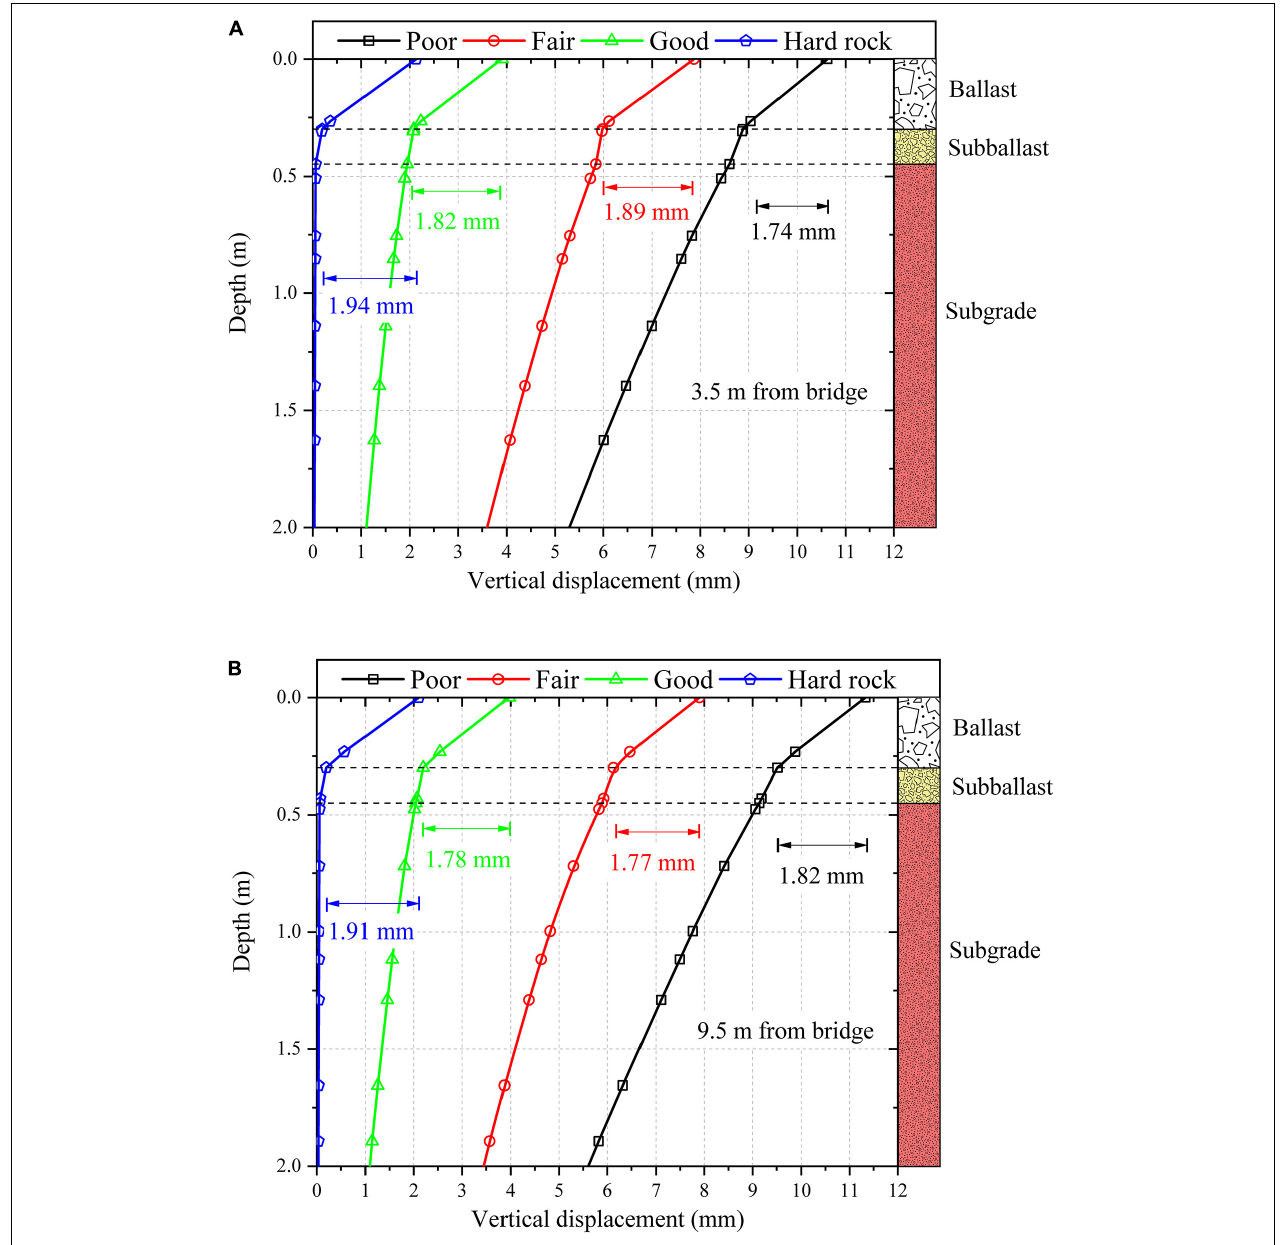
FIGURE 5 | Variation of vertical displacement with depth for four different subgrade types at (A) : 3.5 m from the bridge; (B) 9.5 m from the bridge.